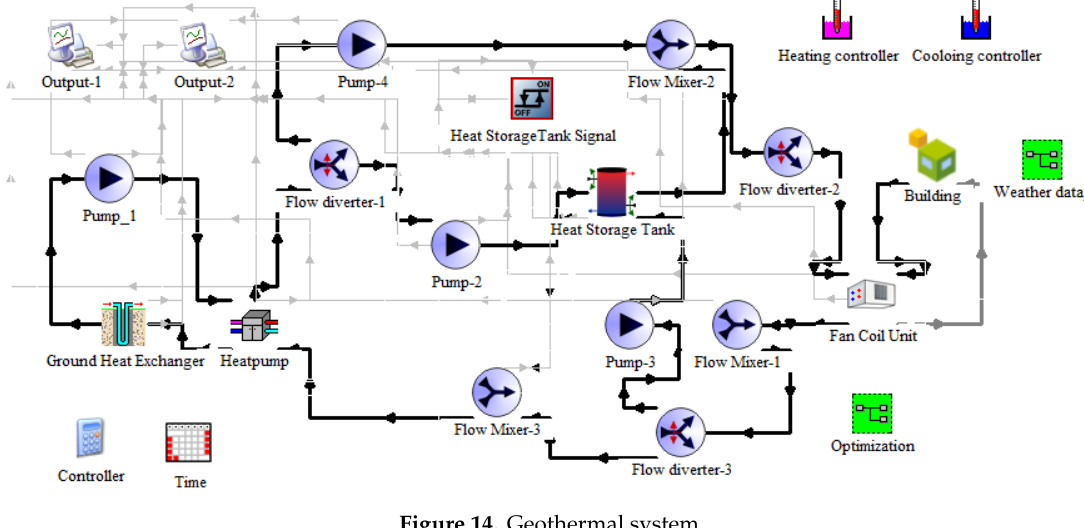
Figure 14. Geothermal system.